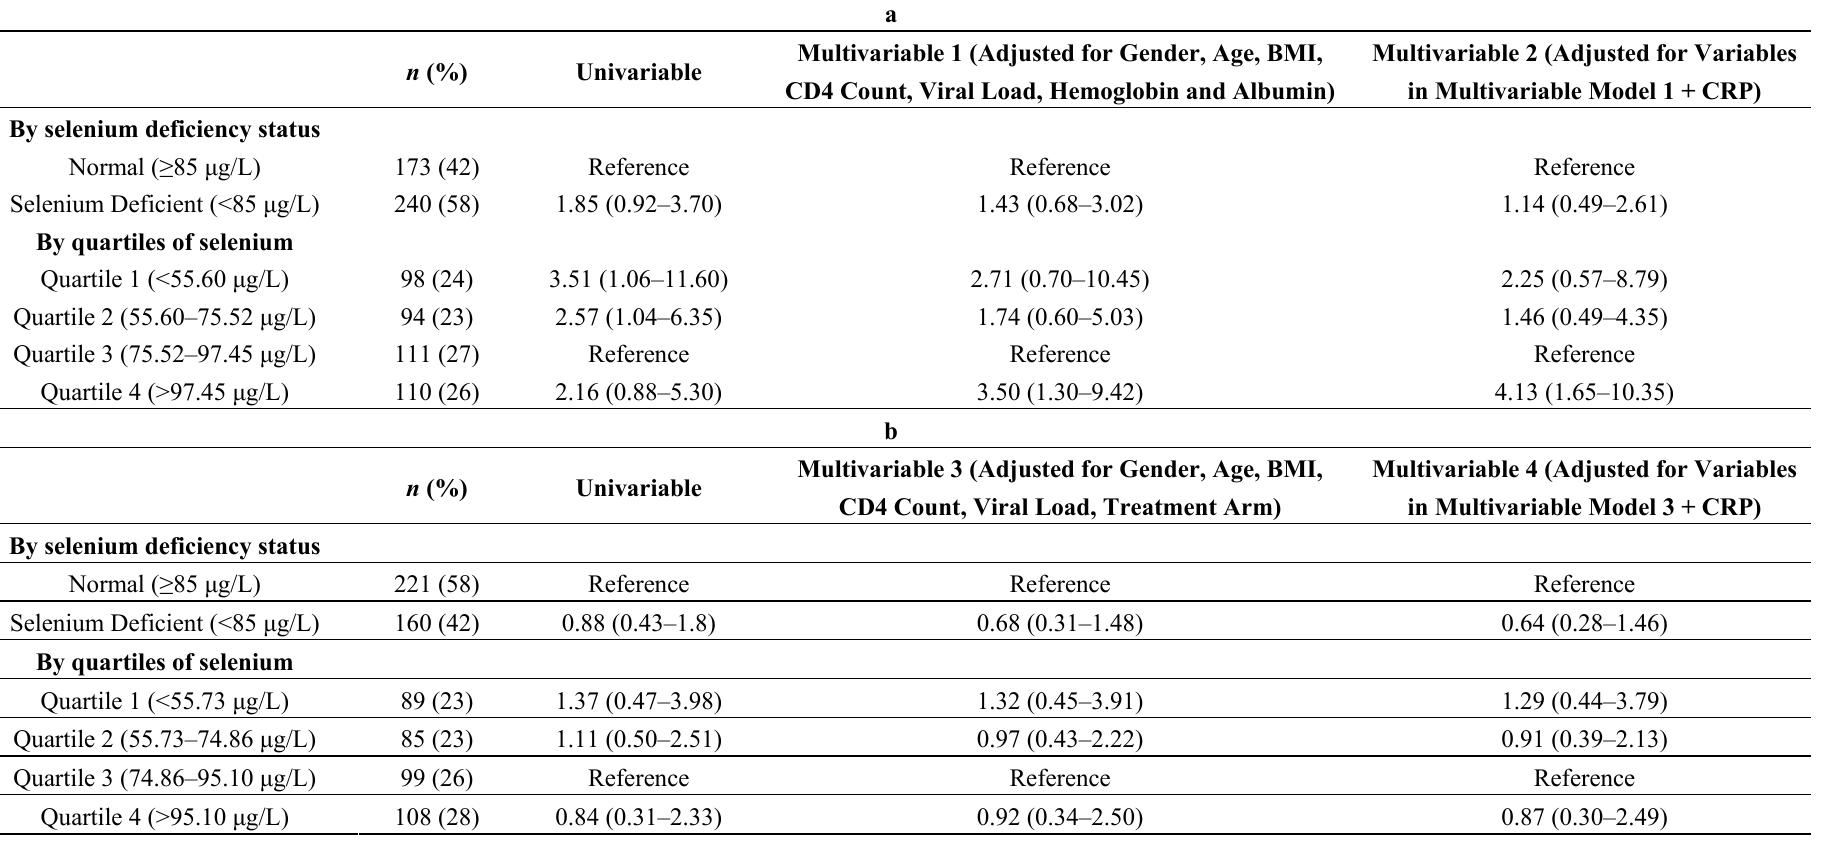
Table 2. ( a ) Association of baseline serum selenium concentrations with clinical treatment failure ( n = 413); ( b ) Association of baseline serum selenium concentrations with virologic failure ( n = 381). Univariable and multivariable cox proportional hazards regression models were used to calculate the hazard ratios to assess the association of serum selenium with clinical treatment failure ( a ) and virologic failure ( b ) in the full case-cohort. The outcome of interest was clinical failure (primary outcome) or virologic failure (secondary outcome). For the univariable and multivariable analyses of clinical failure and virologic failure, serum selenium was categorized as either a binary variable (deficient or not) or as quartiles with the third quartile as the